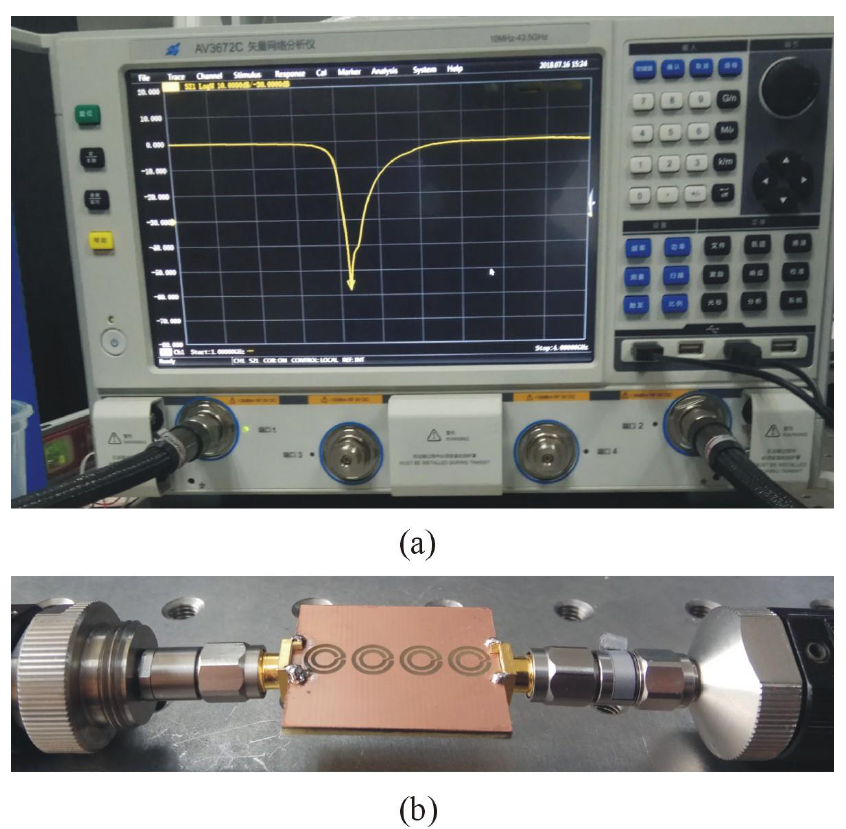
Figure 10. ( a ) Photograph of Vector Network Analyzer (VNA) for measurement of sensor. ( b ) Fabricated prototype of the sensor based on four CCSR.